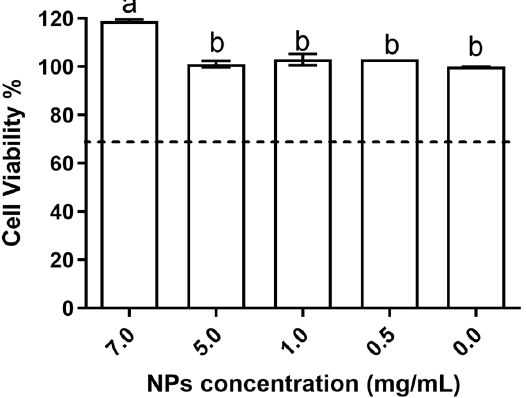
Figure 5. Produced NPs’ biocompatibility with the HaCat cell line at the tested concentrations. Re- sults given in terms of cell viability %. Different letters represent the statistical differences found between conditions assayed. The dotted line represents the 30% cytotoxicity limit as defined by the ISO 10993-5:2009 standard [32].